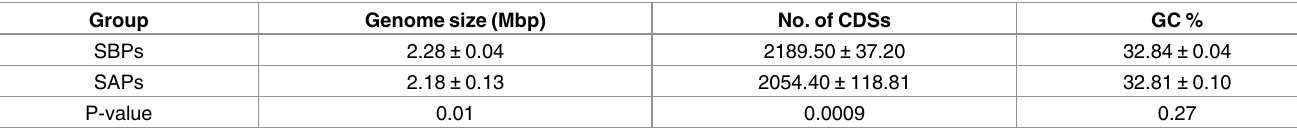
As described above, the isolation conditions of SBPs and SAPs were different. Bacteria that had colonized the animal intestines had acquired antibiotic resistance (AR) genes for their Table 2. Averagesof genomic featuresin SBPs and SAPs (mean ± standard deviation).